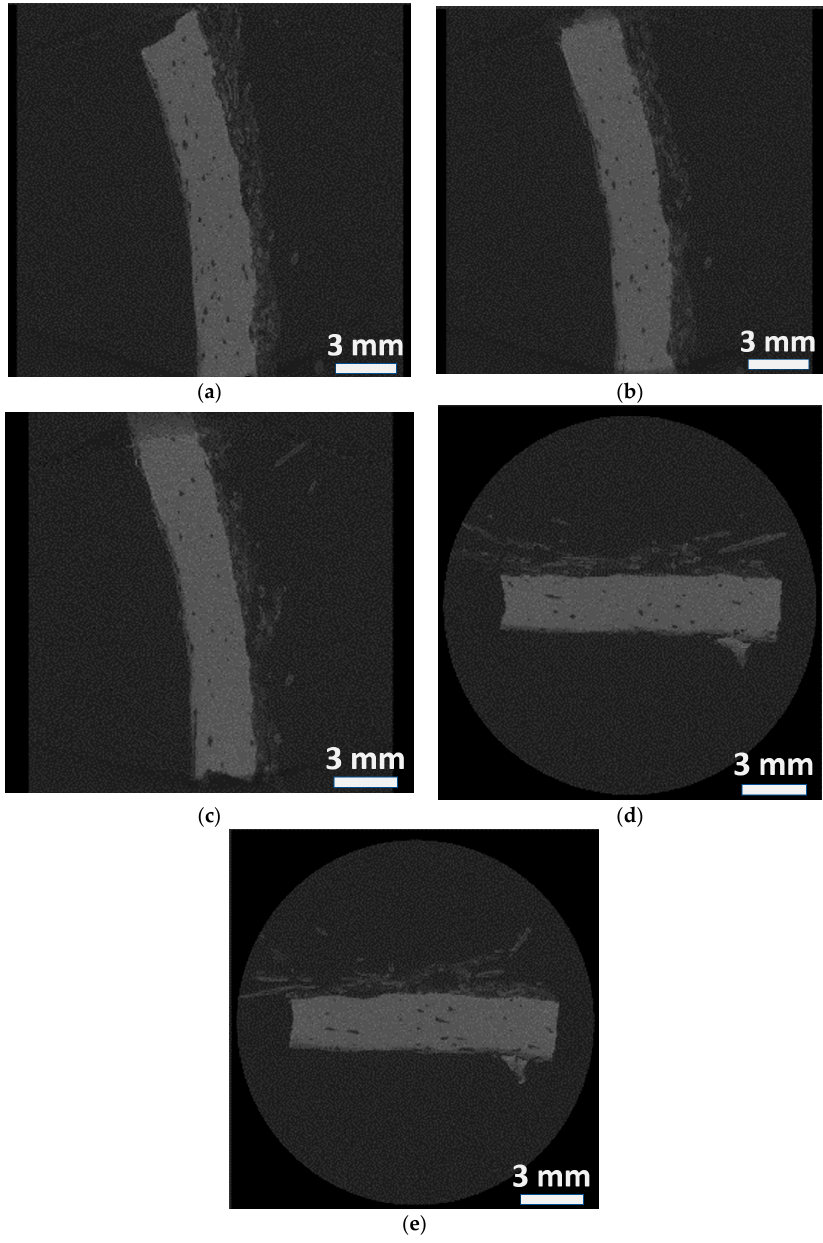
Figure 7. Side (x-z plane) and front (y-z plane) cross-sections of a coconut shell. ( a ) Side cross-section 1; ( b ) Side cross-section 2; ( c ) Side cross-section 3; ( d ) Front cross-section 1; ( e ) Front cross-section 2. For a circular channel, r short = r long , and with respect to an elliptical channel, r short r long . The results of statistical analyses (based on approximate normal distributions) in Figure 8 indicate that the mean values of the radius ratio, r a / t and d top / t are 0.54, 0.06, and 0.58, respectively. Figure 9 indicates that the mean values of a ratio of sine amplitude and period to the shell thickness are respectively 0.32 and 1.92. r short / r long = 0.54 means that the channels are of an elliptical shape and its long axis is about twice as long as its short axis; with d top / t = 0.06, the diameter of the microchannels is approximately 1 / 10th of the coconut shell thickness; when d top / t = 0.58, it indicates that the middle layers are the center place of a distribution. Actually, the distribution in Figure 8c is more like a uniform distribution across the entire coconut thickness except at the places near the top ( d top / t = [0.0,